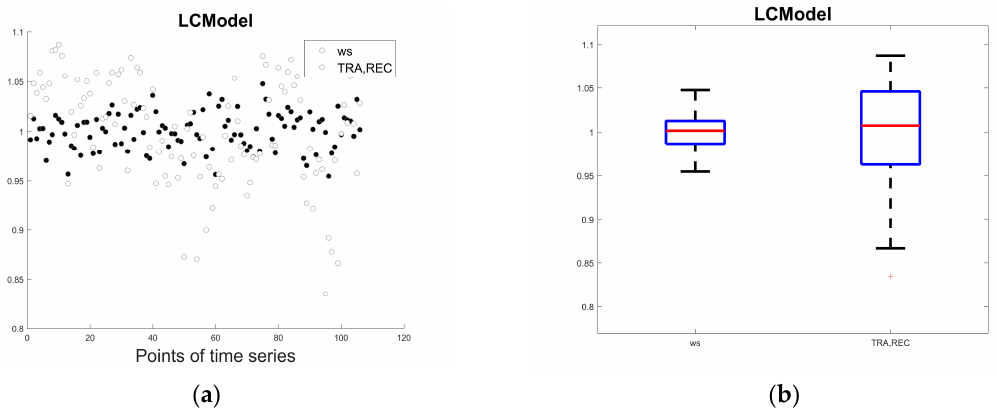
Figure 3. Temporal variability of the water scaled N-acetylaspartate (NAA ws ) and NAA TRA,REC values obtained from short TE 1 H-MRS spectra (TE 35 ms): ( a ) scatterplot; ( b ) boxplot.